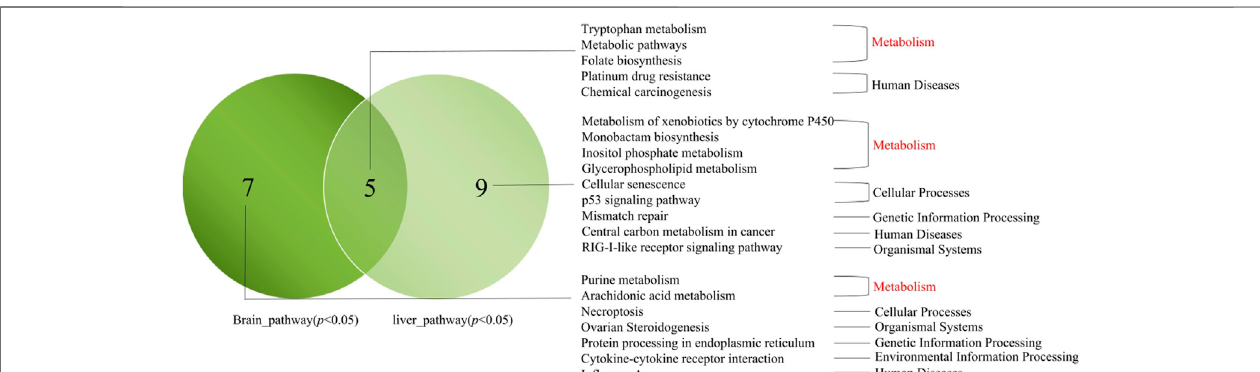
Frontiers in Genetics |